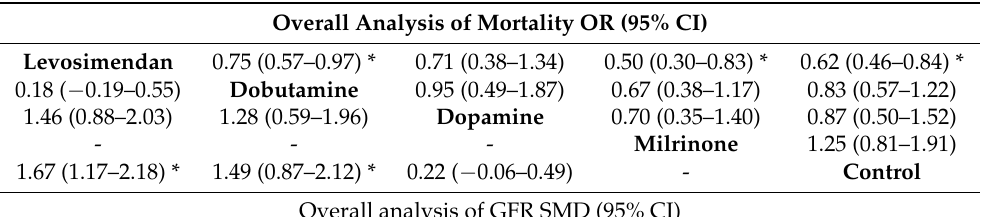
Table 1. Results from the multiple-treatment comparison analyses for mortality (OR [95% Cl]) and GFR (SMD [95% Cl]) in the overall analysis.